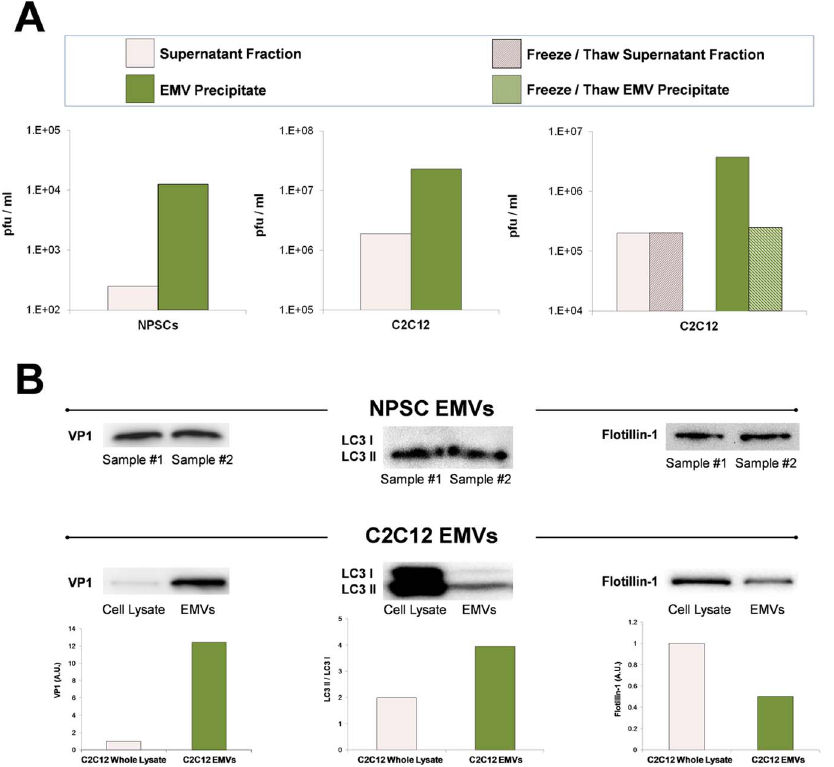
Figure 12. Purified EMVs isolated from infected progenitor cells expressed VP1, LC3 II and flotillin-1 proteins. Shed microvesicles isolated from differentiated C2C12 or NPSC cell cultures infected with eGFP-CVB3 were collected at day 3 PI and purified utilizing the Exoquick-TC polymer-based exosome precipitation kit. (A) Purified EMVs from differentiated C2C12 and NPSC cultures were resuspended with 1 6 PBS, and infectious virus was quantified by standard plaque assay. Levels of infectious virus in EMV precipitates (green bar) were compared to supernatant fractions (pink bar) obtained during the EMV purification procedure. Alternatively, EMV precipitates from infected differentiated C2C12 cells (green hatched bar) and supernatant fractions (pink hatched bar) were freeze/thawed 3 6 prior to virus titer quantification. (B) Purified EMVs were inspected by western analysis for the presence of coxsackievirus viral protein 1 capsid (VP1), LC3 I/LC3 II, and flotillin-1. The levels of VP1 and flotillin-1 were normalized to total protein levels quantified by bicinchoninic assay. The ratio of LC3 II to LC3 I was determined for EMVs and infected C2C12 cell lysates.